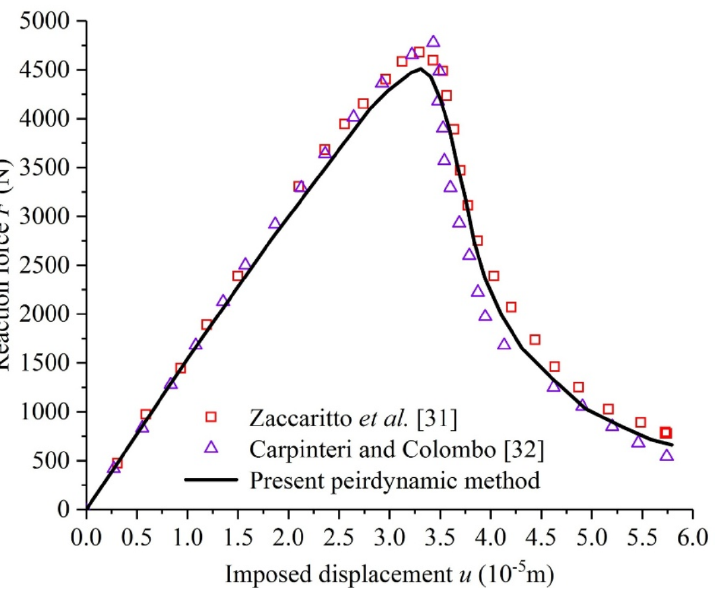
Figure 4. Curves of the reaction force versus imposed displacement obtained by the present method and reference